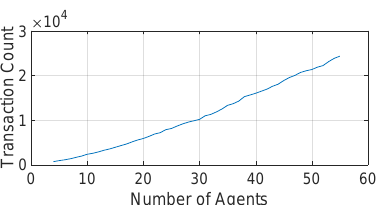
Figure 8. Number of transactions as a function of participating agents.